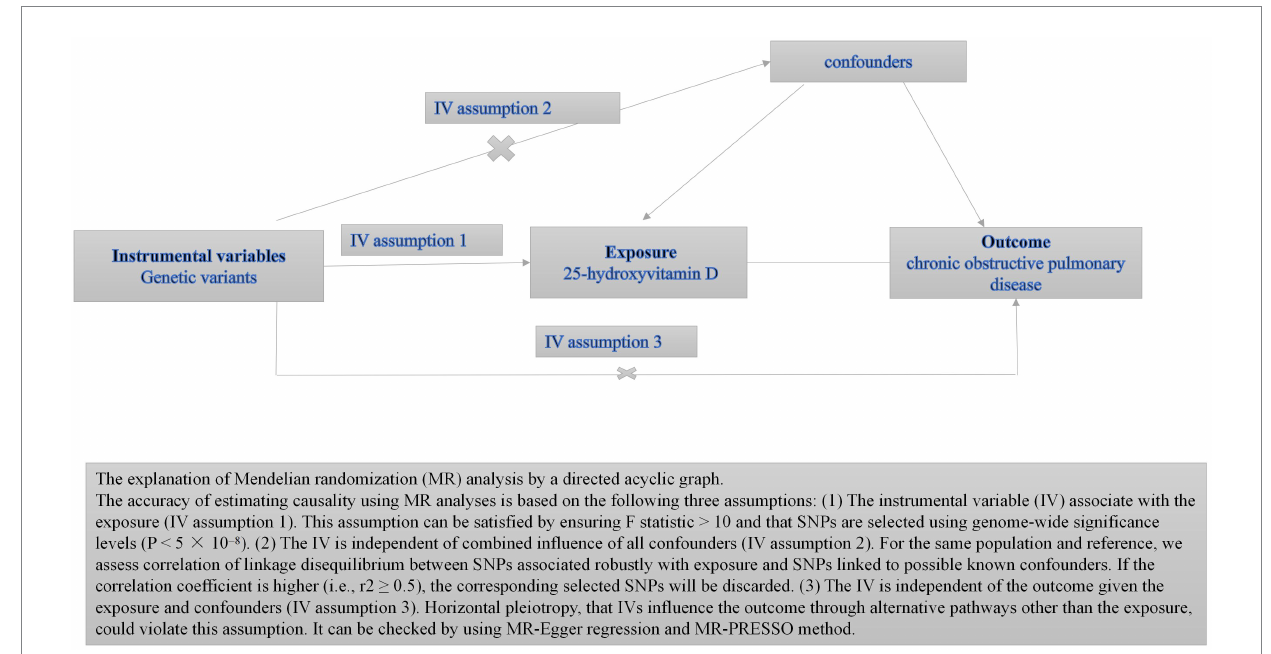
FIGURE 1 Directed acyclic graphs for the classical Mendelian randomization